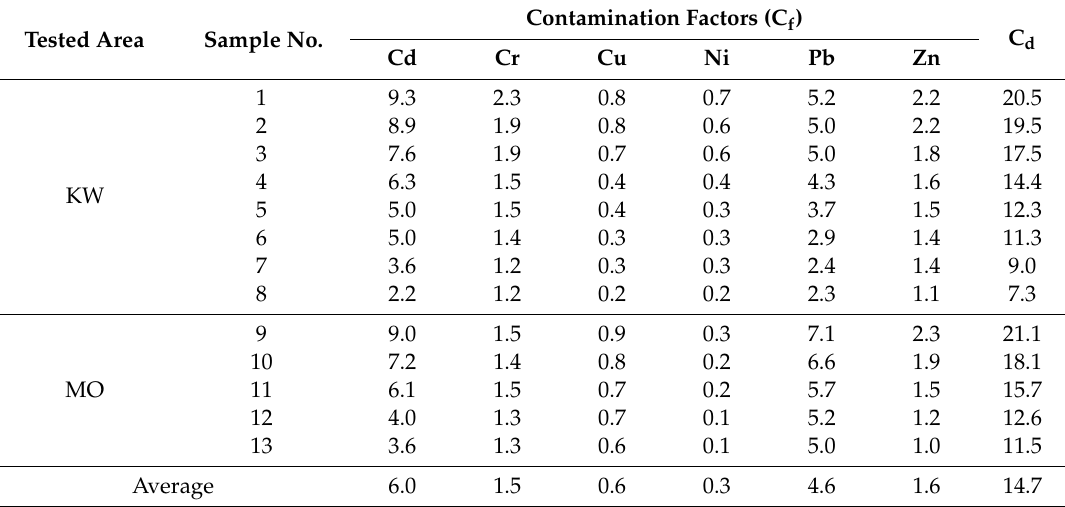
Table 6. Degree of contamination (C d ) and contamination factors (Cf) for soil samples from KW and MO. Tested Area Sample